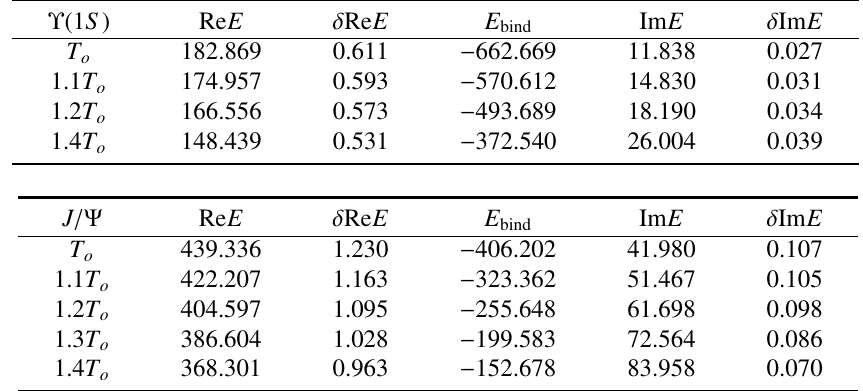
Table 2. The exact 3D results of the complex eigenenergies ( E ) and binding energies ( E bind ) for di ff erent quarkonium states at various temperatures with ξ = 1. δ E are the di ff erences in results obtained using 1D e ff ective and 3D anisotropic potentials. Here T o is 192MeV and all results are in MeV